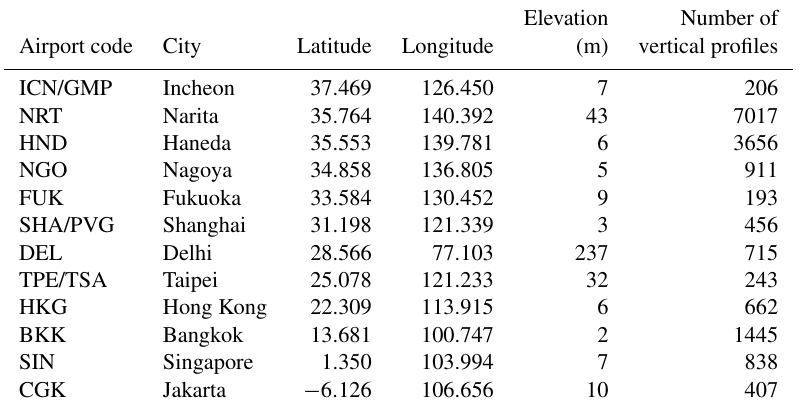
Table 1. List of the major airports of the CONTRAIL CO 2 measurements in the Asia-Pacific region. Vertical profile data taken over neigh- boring airports (listed with two airport codes) were merged for data analysis; note that the airport locations for the first airport code are shown